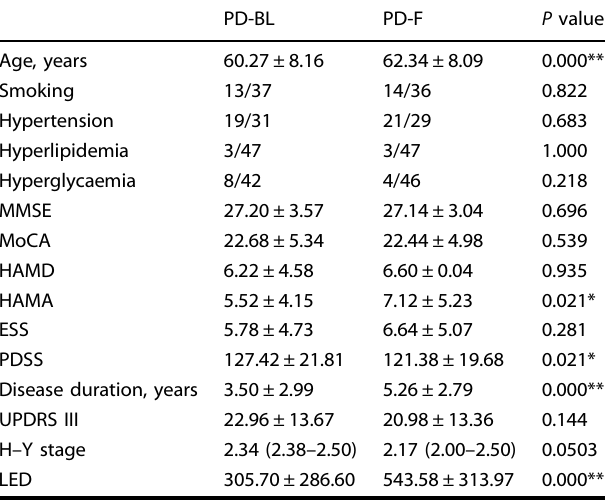
Table 2. Demographics of the follow-up participant